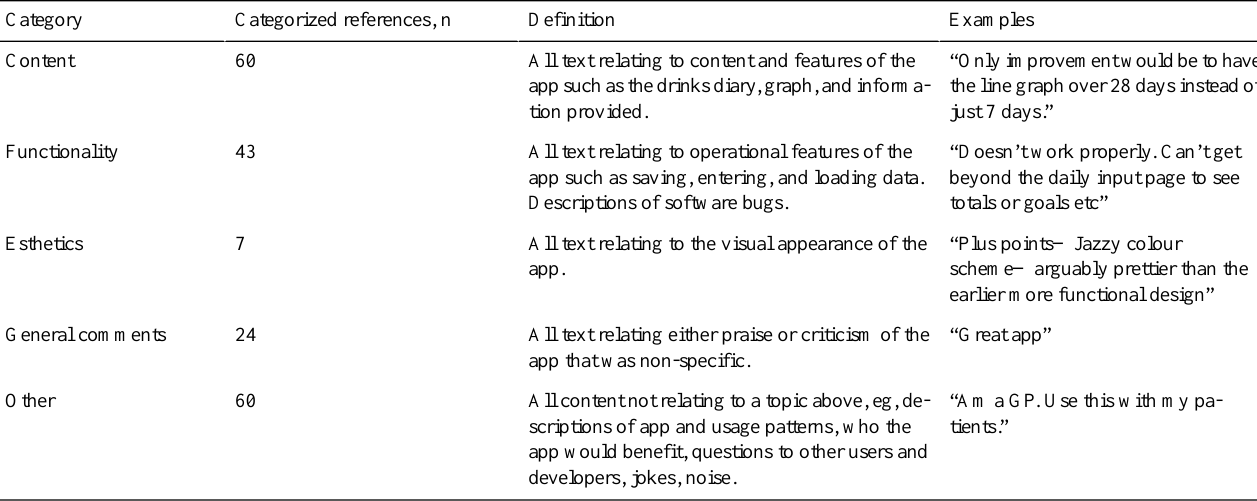
Table 2. Description of coding